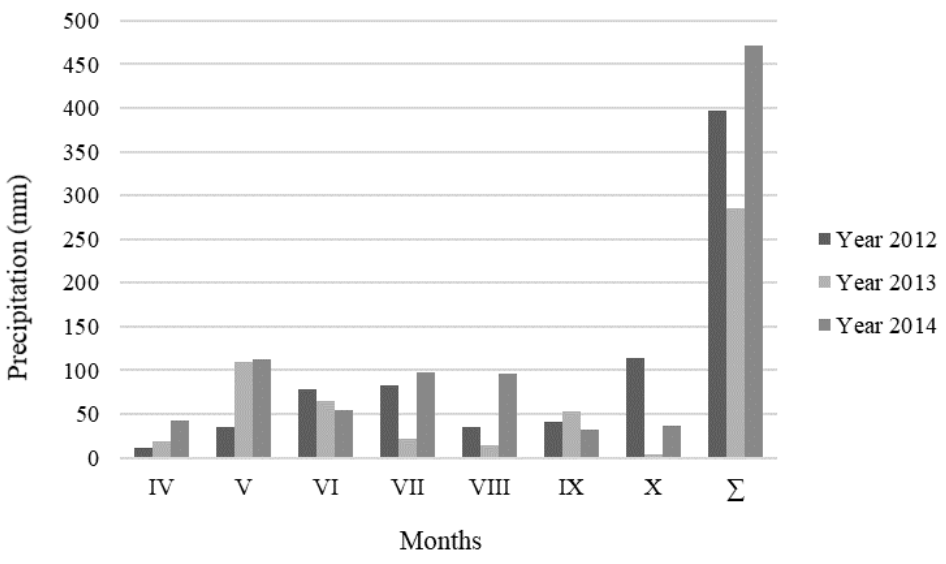
Figure 1. IV—April, V—May, VI—June, VII—July, VIII—August, IX—September, X—October, ∑ — Figure 1. IV — April, V — May, VI — June, VII — July, VIII — August, IX — September, X — October, Sum of precipitation for the season. ∑— Sum of precipitation for the season .